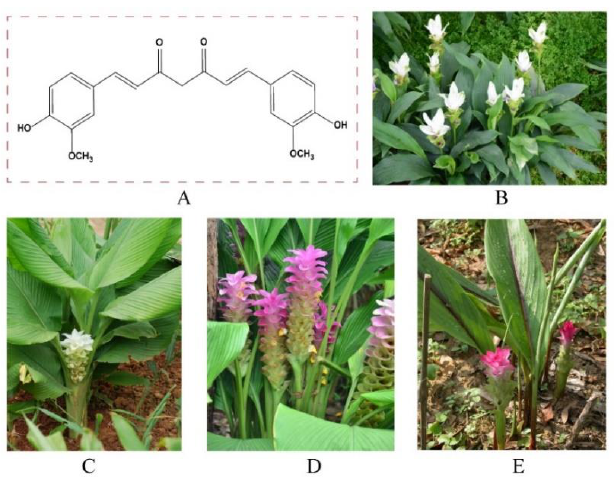
Figure 1. Chemical structure ( A ) of curcumin and its main plant sources (( B ) Curcuma wenyujin Y.H. Chenet C. Ling; ( C ) Curcuma longa L.; ( D ) Curcuma phaeocaulis VaL.; ( E ) Curcuma kwangsiensis S.G. Lee et C.F. Liang). The pictures are from the website: http://www.iplant.cn/frps, accessed on 21 September 2022.